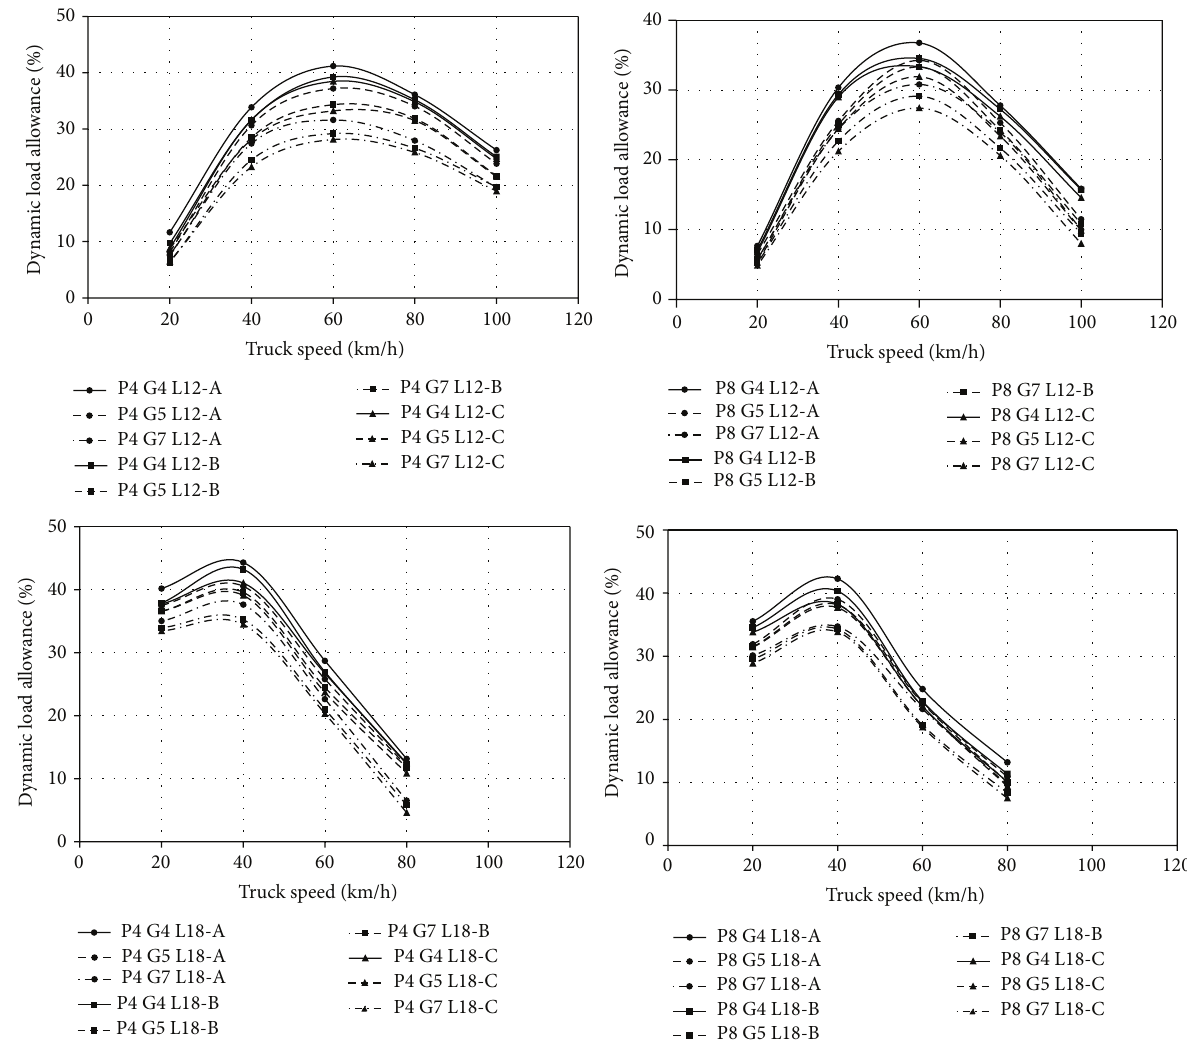
Figure 9: Relations between truck speeds and